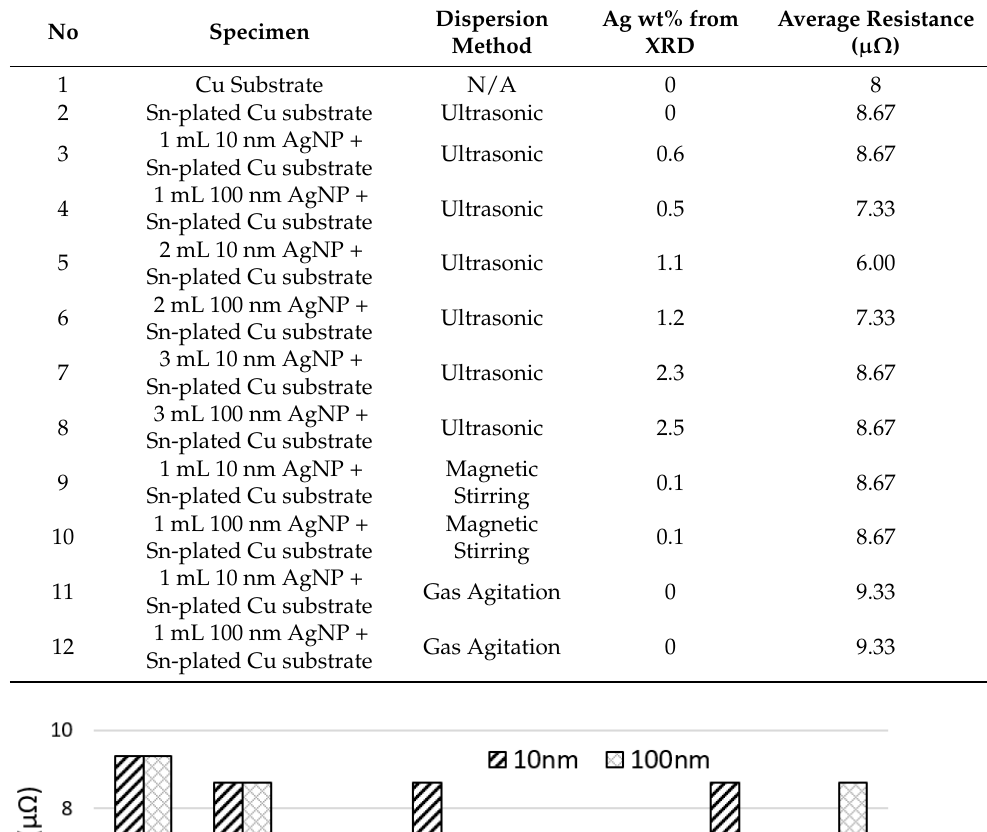
Table 6. Ag wt% and average resistance for different dispersion methods.